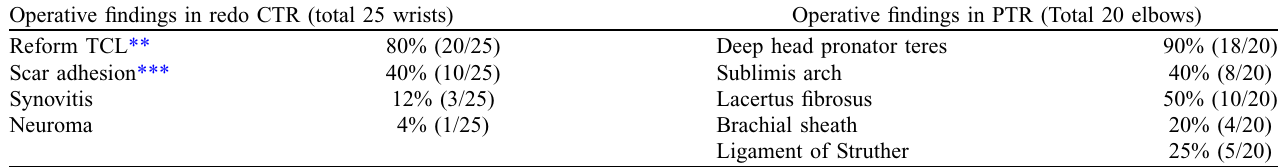
TCL : Transverse carpal ligament. * Operative findings were reported from 22 patients; 25 wrists (19 unilateral and 3 bilateral CTR), and 20 elbows (14 unilateral and 3 bilateral PTR). **, *** 4/25 wrists (16%) with reform TCL and 6/25 wrists (24%) with scar adhesion have clear evidence of pressure effect to median nerve including disproportion of median nerve, hour-glass appearance, or tight scar around the median nerve that need external neurolysis.